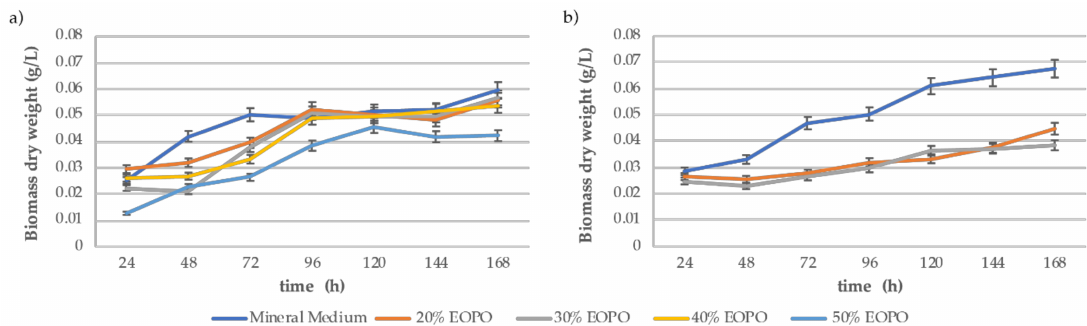
Figure 3. Biomass production in submerged fermentation of Rhodotorula mucilaginosa UANL-001L cultures in presence of ( a ) EOPO 970 or ( b ) EOPO 12,000. Cultures were maintained in liquid medium on sterile conditions and kept in incubation for 3 days at 30 ◦ C and 250